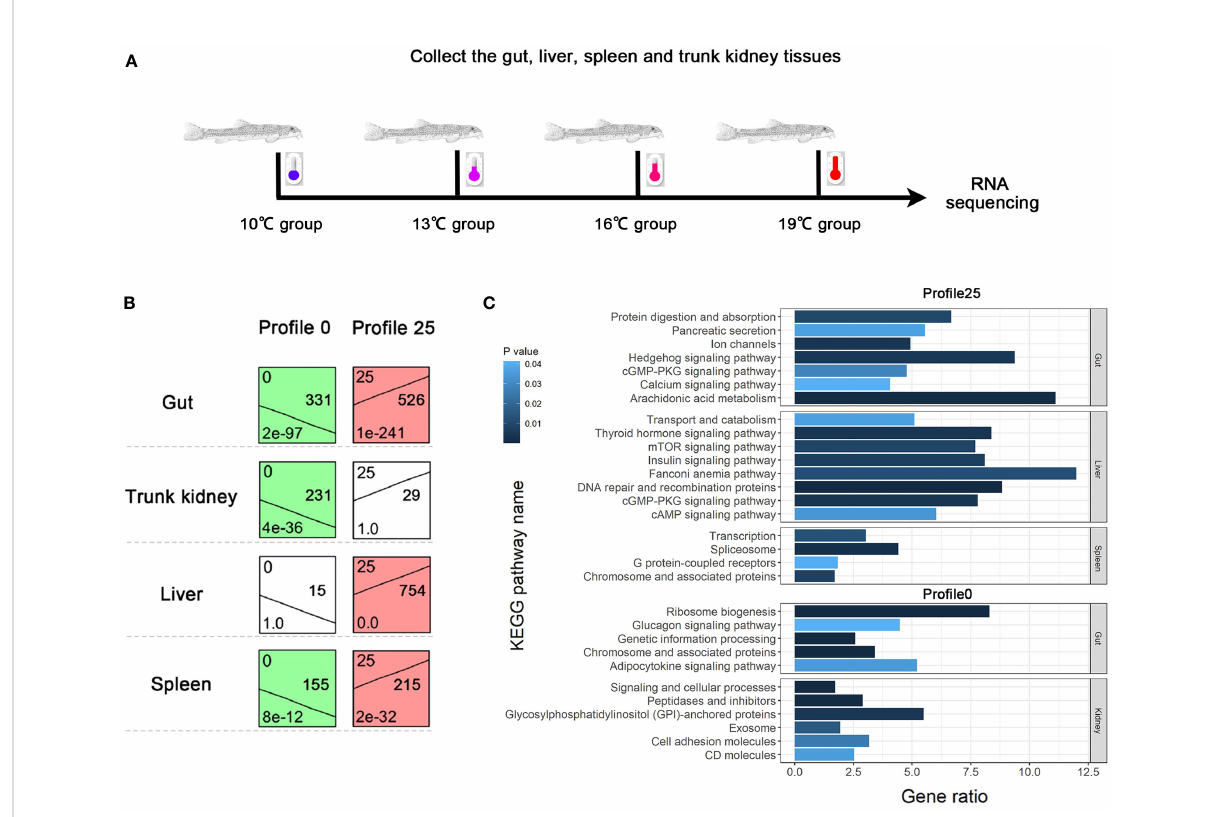
FIGURE 2 Dynamic expression pro fi les of genes with increasing temperature. (A) Temperature conditions and sample collections. (B) Expression patterns of consistently increasing and decreasing genes identi fi ed by STEM analysis. (C) KEGG enrichment results of genes belonging to pro fi le 0 and